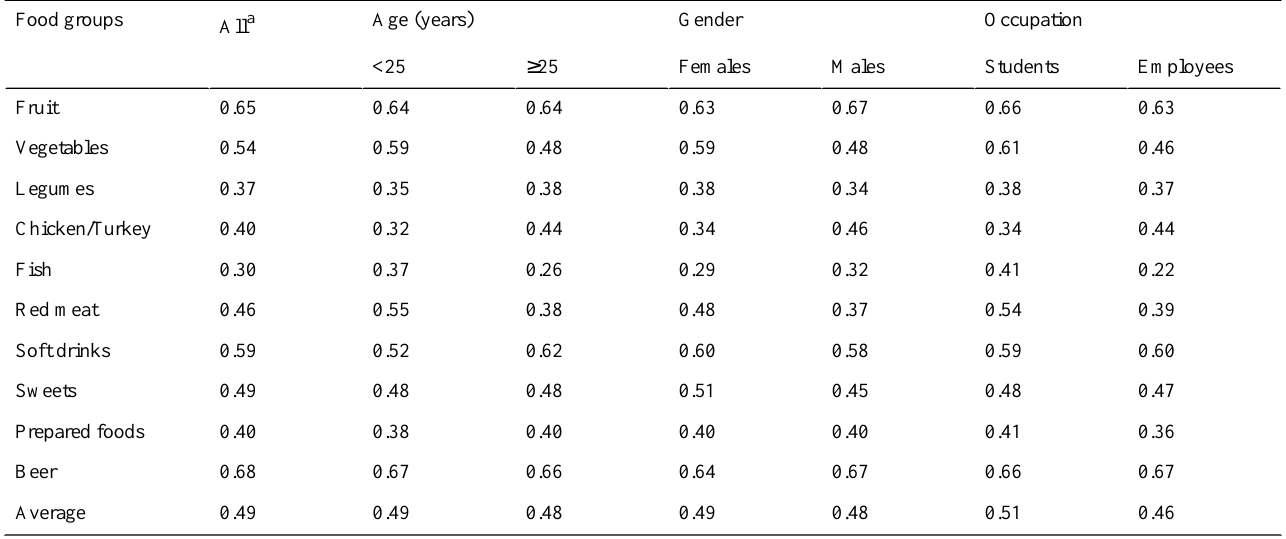
Table 6. Weighted kappa derived from the electronic 12-hour dietary recall app versus the food frequency questionnaire for categories of food group consumption and strata: age (years): <25 and ≥ 25; gender: females and males; and occupation: students and employees. Comparison of the electronic 12-hour dietary recall app versus the food frequency